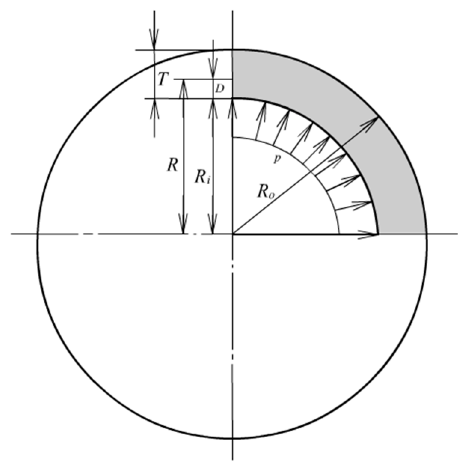
Figure 10. A thick-walled balloon subjected to internal pressure.